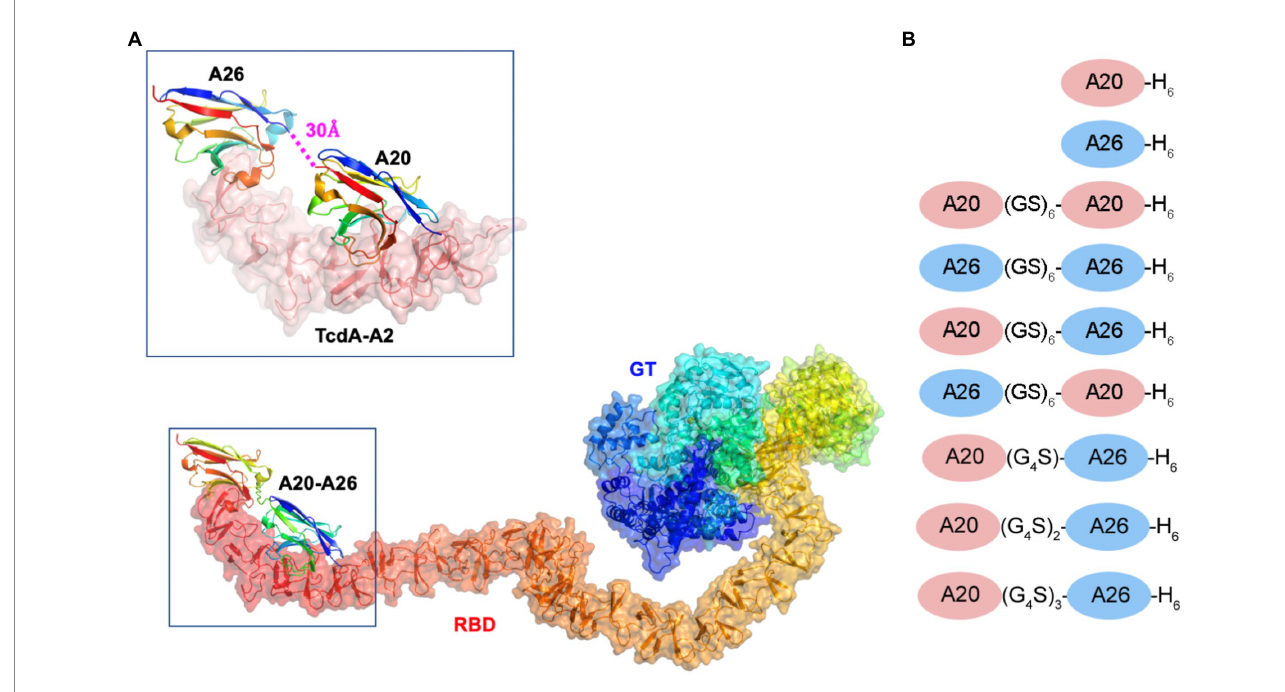
FIGURE 1 Model of the A20-A26 fusion protein bound to the CROPs domain of Clostridioides difficile TcdA. (A) The structure of full-length C. difficile TcdA was generated by superimposing the crystal structure of the N-terminal 1832 amino acid residues of TcdA (4R04) (Chumbler et al., 2016) onto the crystal structure of TcdB (6OQ5) (Chen et al., 2019). To model the CROP domain missing from the TcdA structure, we made the assumption that the orientation of the CROP domain relative to the N-terminal domains is similar in the two toxins. By superimposing the N-terminal short repeat of a model of the TcdA CROP domain (Ho et al., 2005; Pruitt et al., 2010; Pruitt and Lacy, 2012) onto the N-terminal short repeat in the CROP domain of TcdB (6OQ5), a model of full-length TcdA was generated. The resulting model shows similar features to the low resolution cryo-EM envelopes of full-length TcdA (Pruitt et al., 2010; Pruitt and Lacy, 2012). The structure of the complex formed between A20-A26 and TcdA was generated by modeling the structure of a (GS) 6 linker in an extended antiparallel β -strand conformation using PyMOL and positioning this linker between the C-terminus of the A20 V H H and the N-terminus of the A26 V H H observed in the crystal structure of the complex formed between A20, A26 and the TcdA-A2 fragment (4NC1) (Murase et al., 2014). TcdA is shown in cartoon ribbon and semi-transparent surface representations. A20, A26 and the A20-A26 V H H domains are drawn in cartoon representation. Each polypeptide chain is colored according to the colors of the rainbow, starting from blue at the N-terminus to red at the C-terminus. RBD, receptor binding domain; GT, glucosyl transferase. (B) Schematic representation of the V H H constructs generated in this